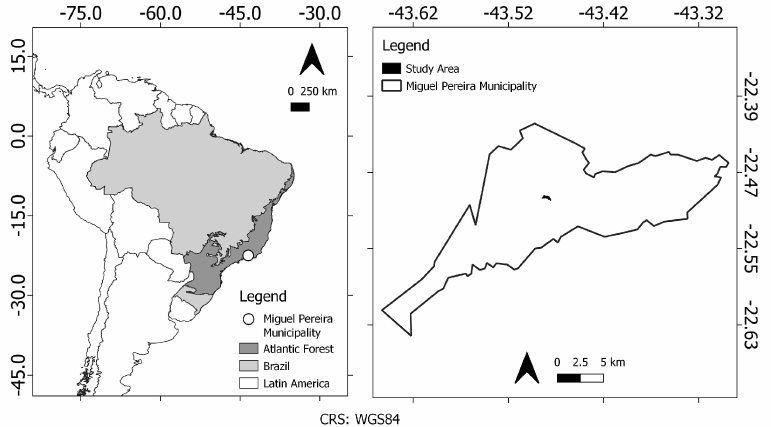
Figure 1. Location of the FR study area on Miguel Pereira municipality, situated in the Brazilian Atlantic Forest biome. To see the RPA orthomosaic and the study area on a greater scale, please go to Figure